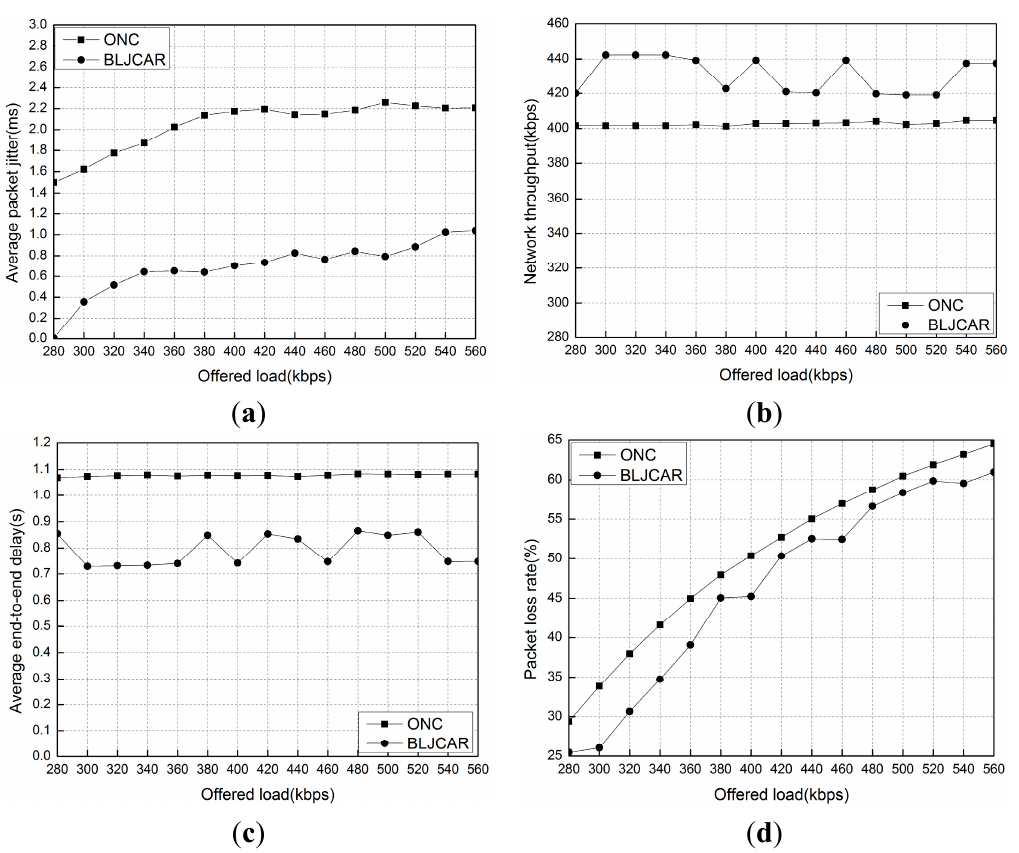
Figure 7. ( a ) Average packet jitter versus offered load; ( b ) Network throughput versus offered load; ( c ) Average end-to-end delay versus offered load; ( d ) Packet loss ratio versus offered